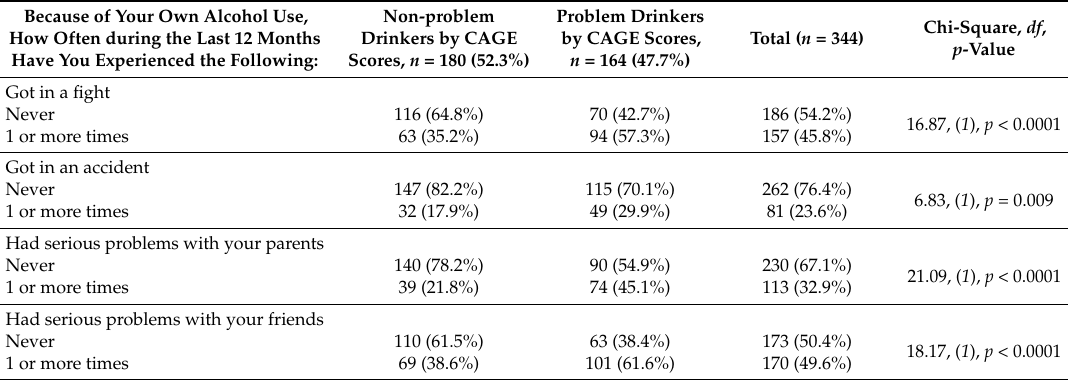
Table 2. Alcohol-related violence and problem drinking among youth living in the slums of Kampala, Uganda ( n =